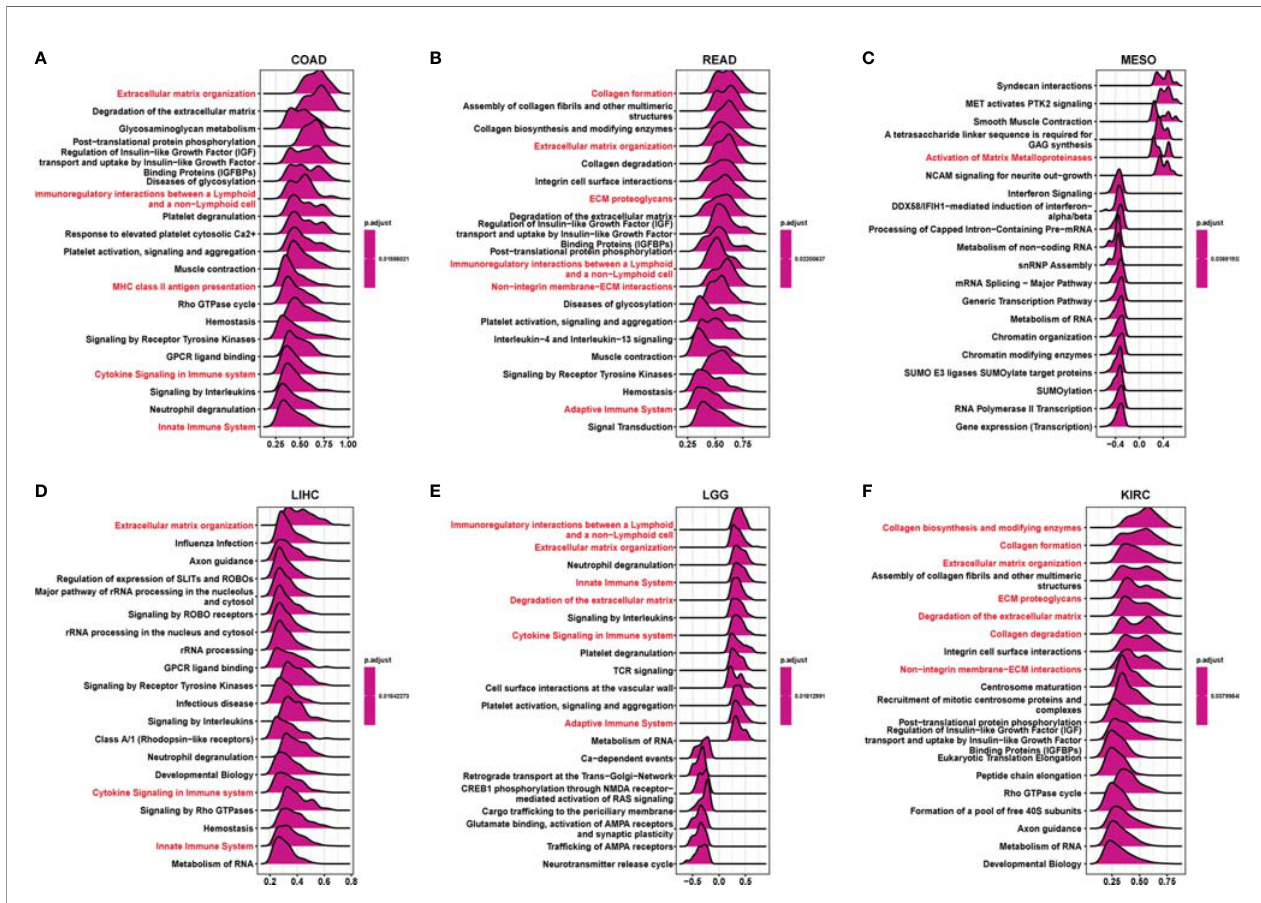
FIGURE 6 | Gene Set Enrichment Analysis (GSEA) of tumor samples with expression of RCN3. (A – F) The plot showing the top 20 categories enriched in GO analysis via GSEA. The extracellular matrix related pathways and immune-related regulation mechanisms (red) were the main enriched terms in a large fraction of cancers, such as COAD, READ, MESO, LIHC, LGG, and